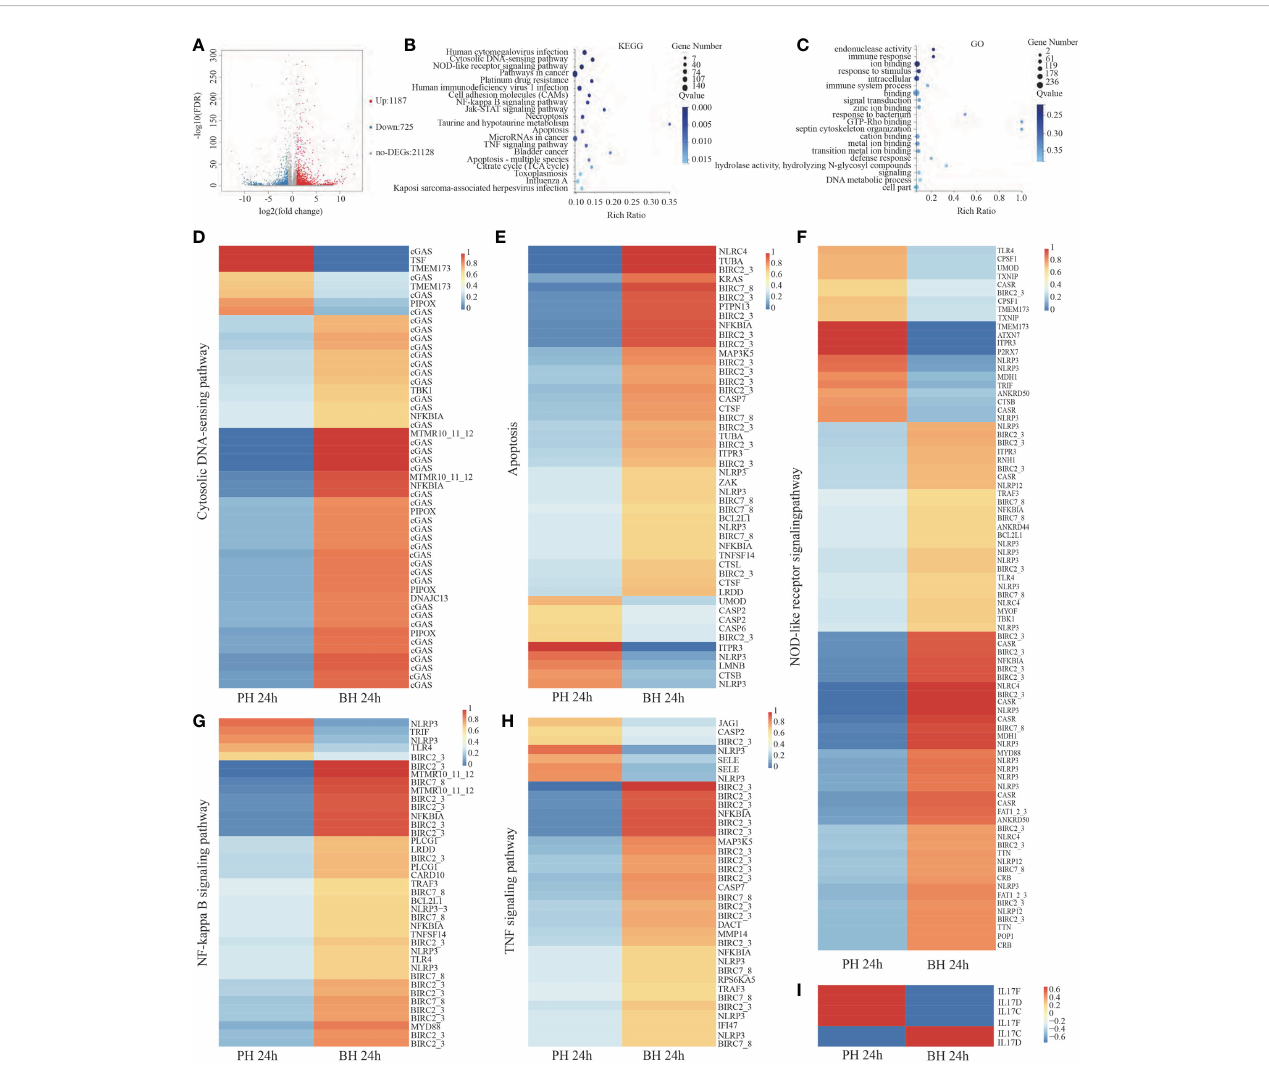
FIGURE 4 Analysis of DEGs between PH and BH group after transplantation 24 (h) (A) . Volcano map of DEGs between PH and BH groups after transplantation 24 (h) Impacted pathway (B) and GO (C) of butyrate on the genes regulated by transplantation. Expression of the related genes in the Cytosolic DNA sensing pathway (D) , Apoptosis (E) , NOD-like receptor signaling pathway (F) , NF-kappa B signaling pathway (G) , TNF signaling pathway (H) , IL 17 (I) in PH and BH groups after transplantation 24